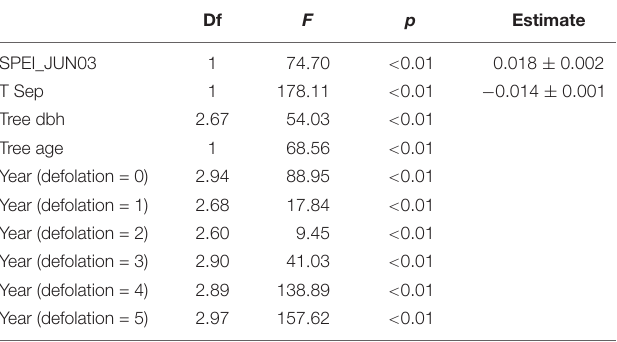
The model was fitted to tree as a function of their defoliation degree, from low (class 1) to complete (class 5) defoliation. For each variable, the degrees of freedom (Df), F statistic and associated probability (p) are shown. For the linear terms of the model (SPEI_JUN03 and T Sep) the estimated regression coefficient and standard error ( ± 1 SE) are shown.